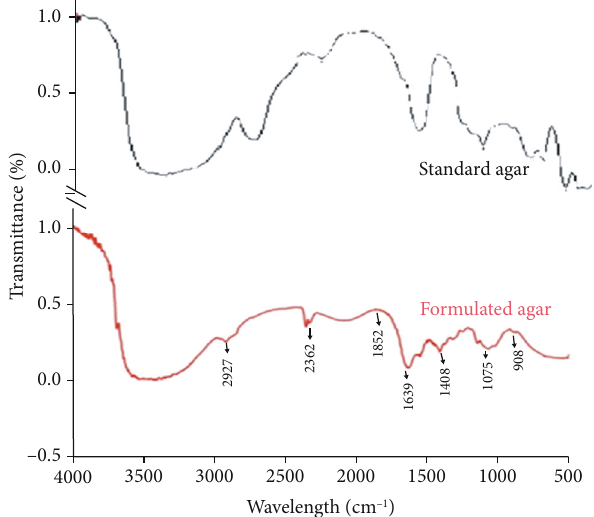
Figure 2: FT-IR spectrum of formulated agar.